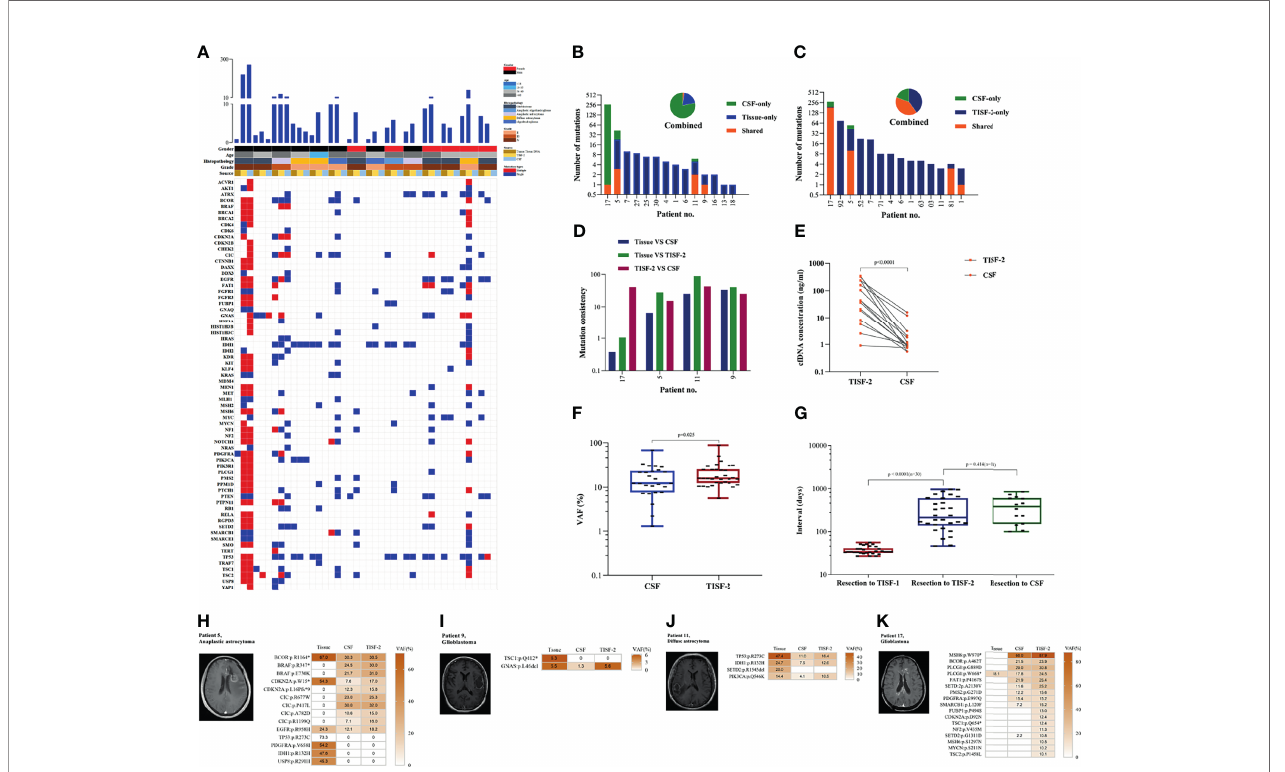
FIGURE 4 | TISF is a more abundant source of tumor DNA. (A) The gene mutation pro fi les of the paired samples were in CSF and TISF. (B, C) Shared mutations in paired samples of CSF, tissue, or TISF (n = 14). (D) Mutation consistency analysis of CSF and matched tumor tissue and TISF samples. (E) cfDNA concentration in CSF and TISF-2. (F) CSF and TISF-2 mutated gene VAF. (G) The time interval between sample acquisition. (H – K) The four patients with positive CSF were found to have recurrent tumors with close communication with the ventricle and cistern, and the tumor burden was large. VAF of the trunk mutation was elevated at progression, but VAF was lower in CSF than in